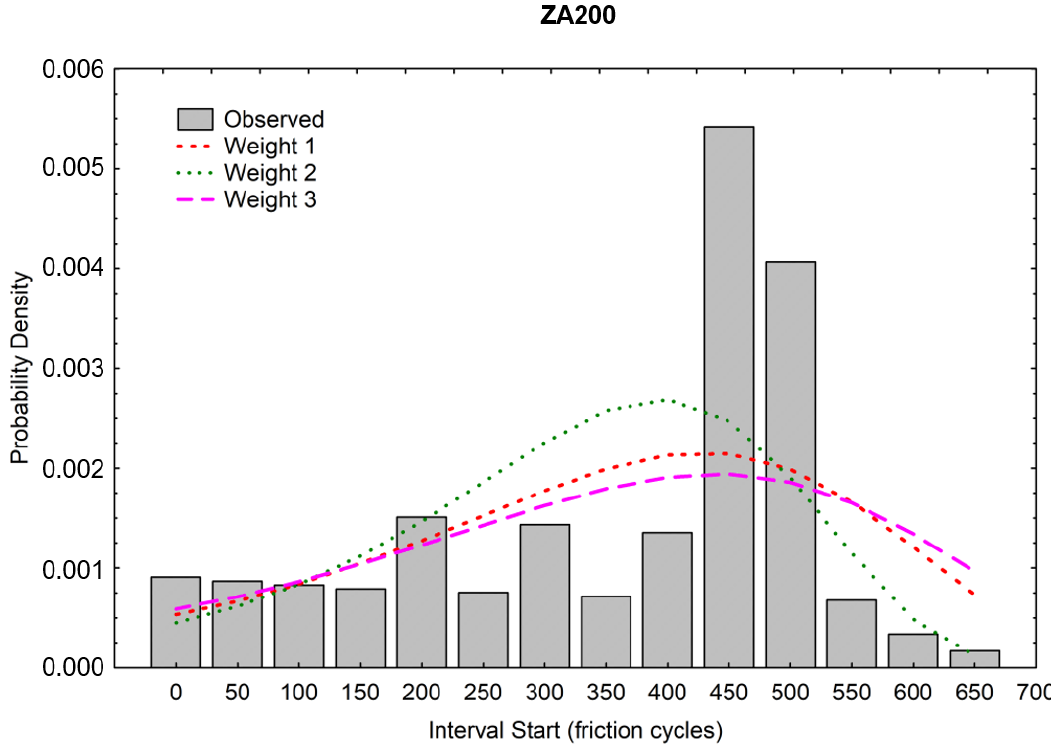
Figure 15. Probability density of the wear of the ZA200 coating.